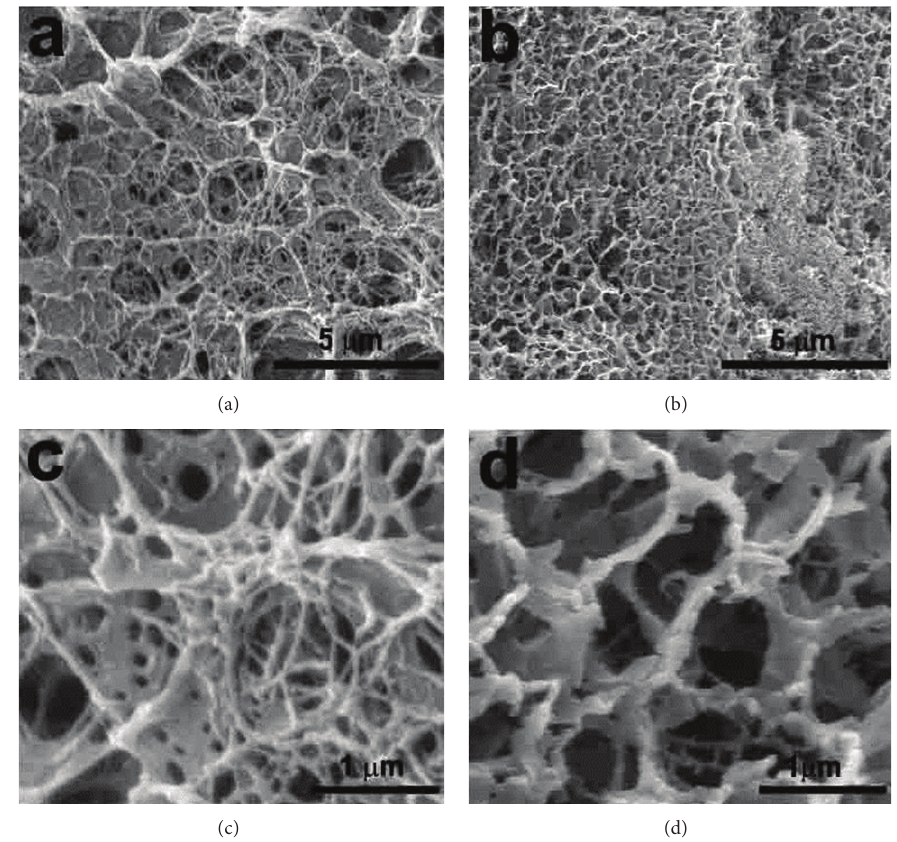
Figure 4: FE-SEM images of cellulose/MWCNTs hydrogel Gel 5: surface ((a), (c)) and cross section ((b), (d)).